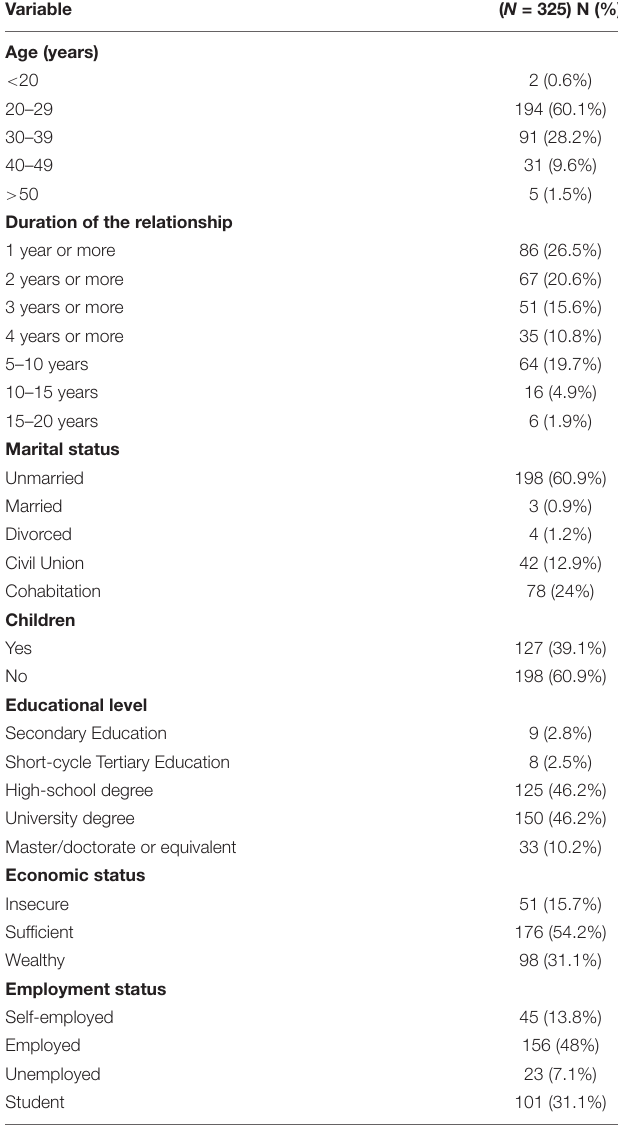
TABLE 1 | Demographic and socioeconomic characteristics of